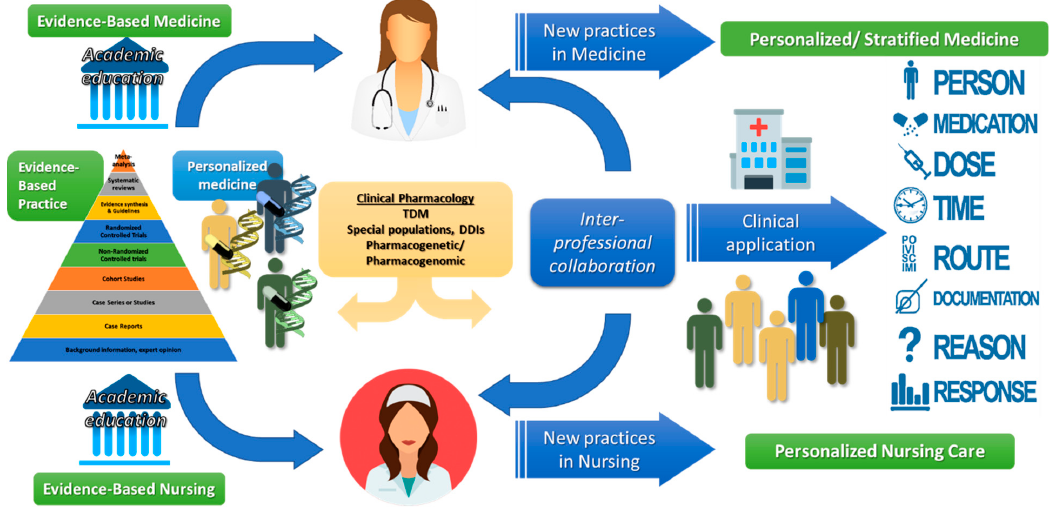
Figure 1. The role of nursing personnel (NP) in utilizing knowledge and interpreting instructions derived from treating physicians in clinical settings toward personalized medicine and nursing care.